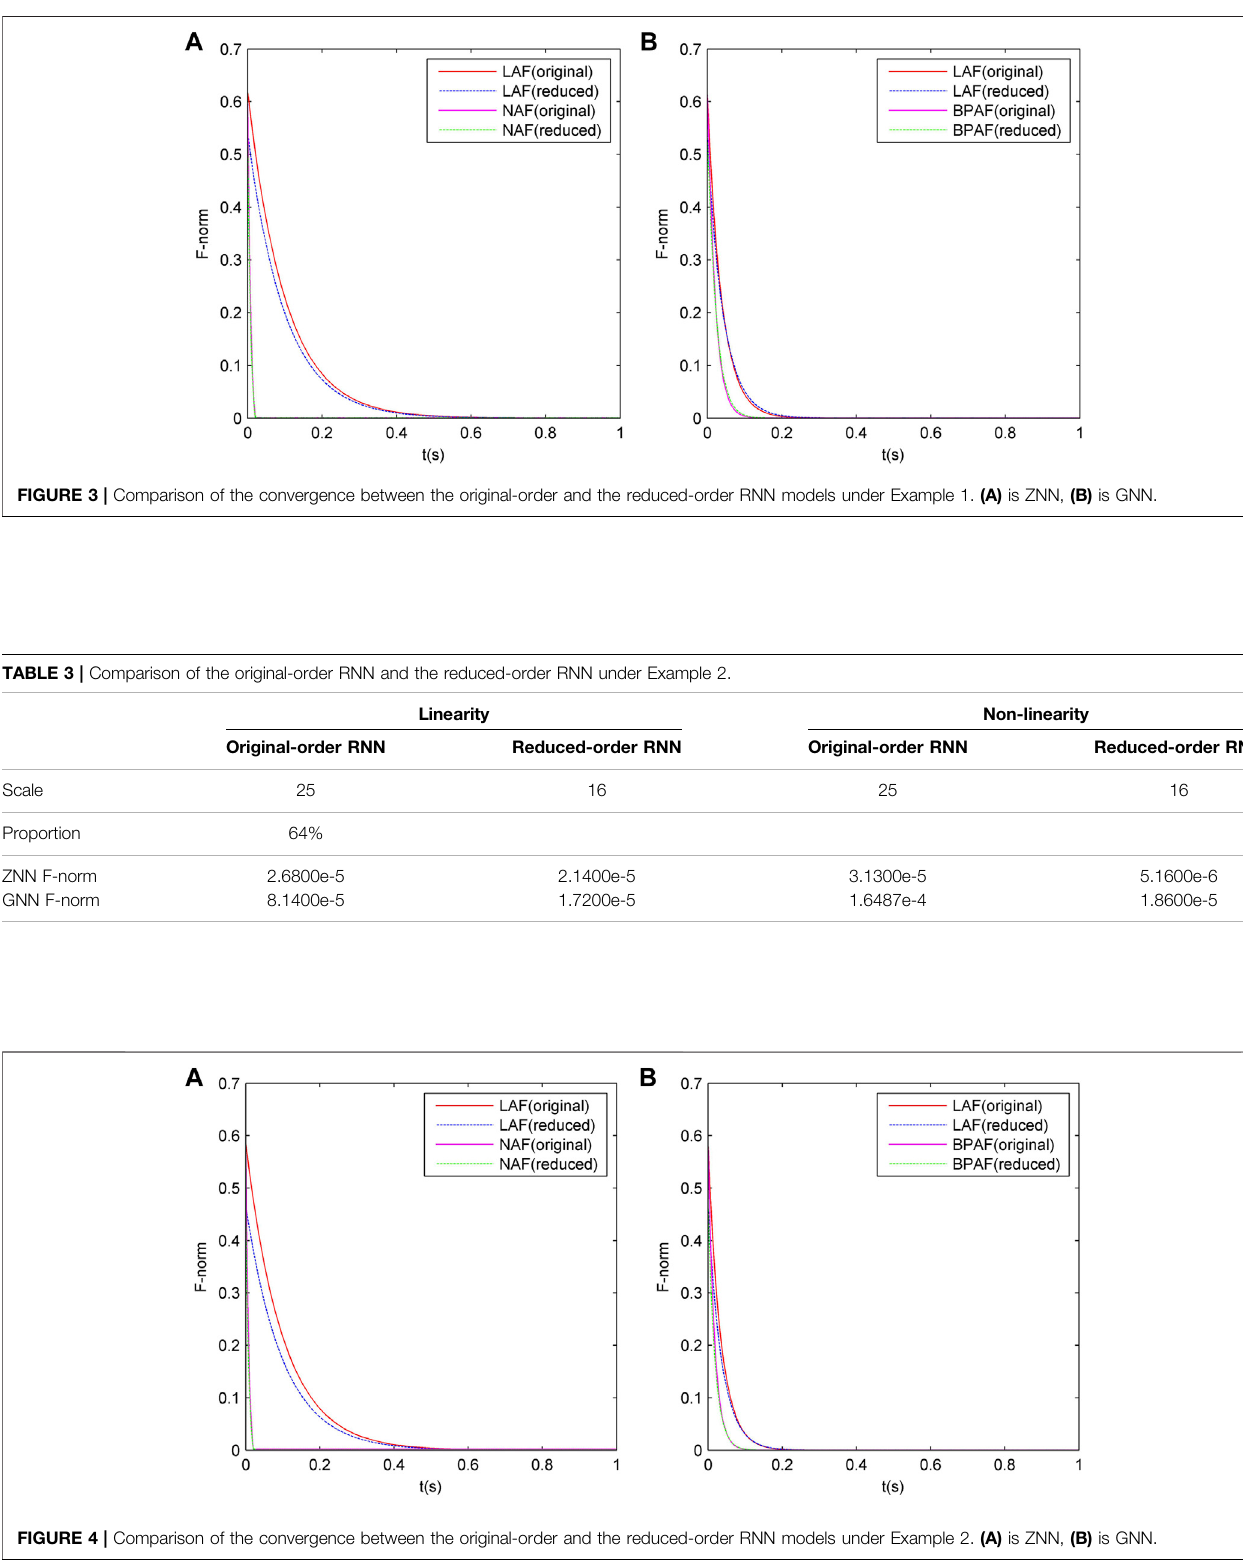
Frontiers in Energy Research |